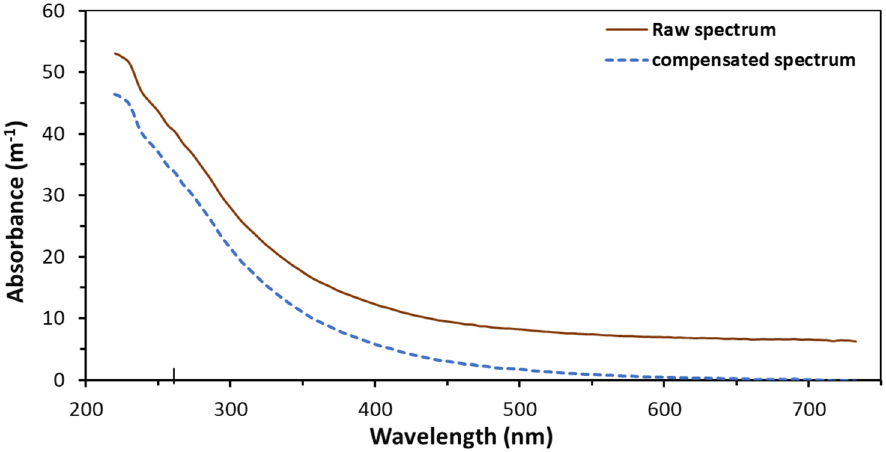
Figure 1. Illustration of particle compensation of a raw spectrum for surface water using a single- wavelength method.